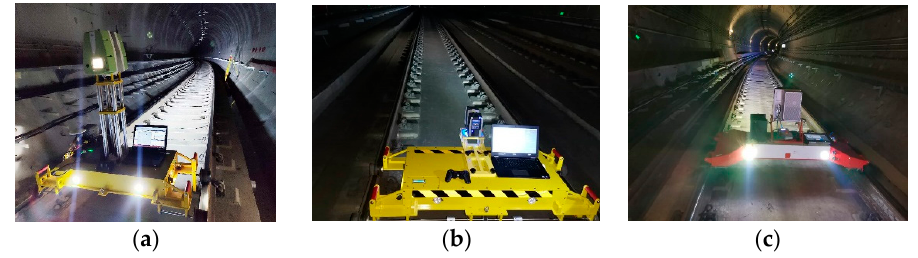
Figure 11. Operation photos of ( a ) Leica ( b ) Faro ( c ) Z + F.